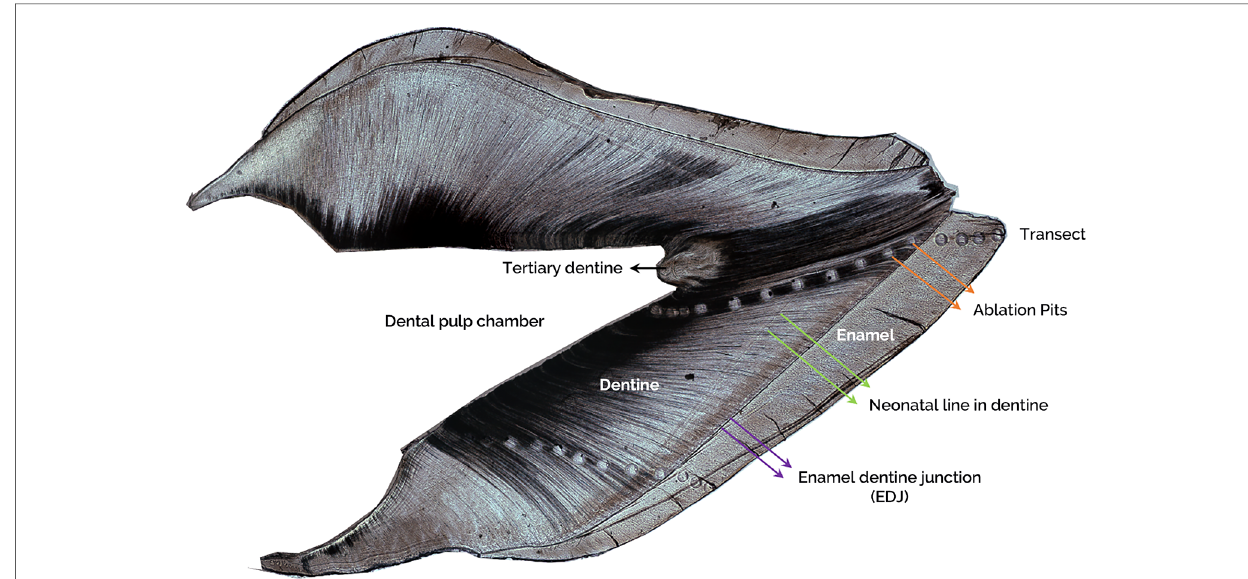
FIGURE 1 A representative image of a longitudinal ground tooth section of an incisor. Labelling shows the enamel, enamel dentine junction (EDJ, purple arrows), dentine, neonatal line (NL, green arrows), ablation pits in the transect (orange arrows), dental pulp chamber (DPC), and tertiary dentine (black arrow).